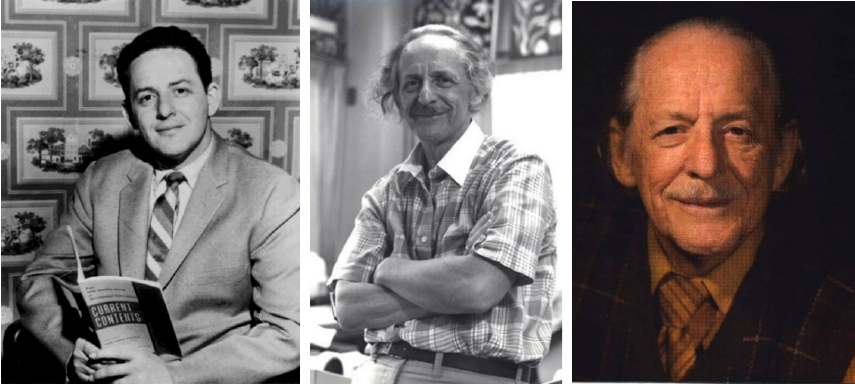
Figure 4. Pictures of Eugene Garfield that accompanied his essays in Current Contents . With permission from Eugene Garfield’s personal archive. Publications 2019 , 7 , x FOR PEER REVIEW